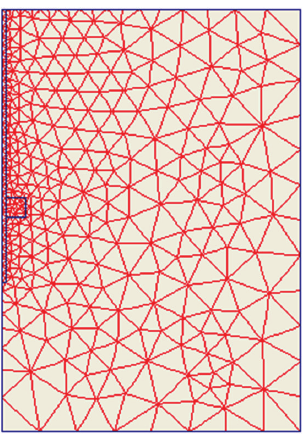
Figure 5: Mesh generation for pressuremeter model.